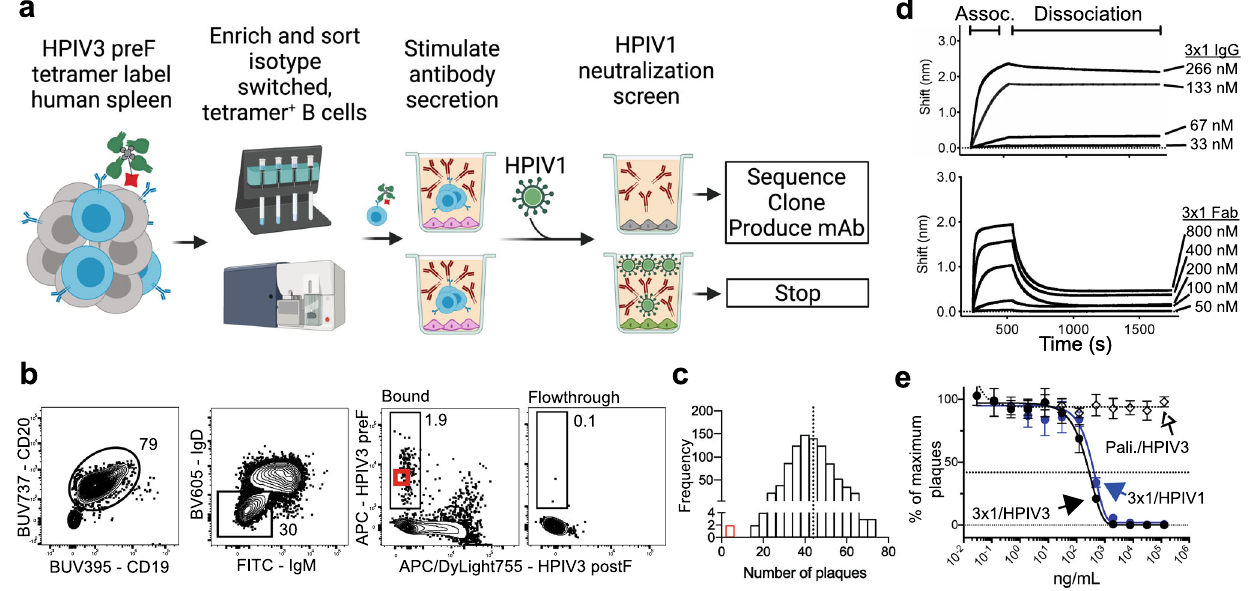
Fig. 1 | Identi fi cation of an HPIV3/HPIV1 cross-neutralizing monoclonal anti- body. a Bait-and-switch approach using a single antigen to identify B cells that cross-neutralize another related virus. HPIV3-binding B cells from human spleen were labeled with APC-conjugated tetramersofHPIV3 preF. b Flow cytometryplot of HPIV3 preF-binding B cells after gating for live, CD3 − CD14 − CD16 − CD19 + CD20 + (B cells), IgD − /IgM − (isotype-switched), and APC/Dylight755 − HPIV3 postF − (to exclude cells binding to HPIV3 postF, APC, or streptavidin). The bound fraction contains cells magneticallyenriched cellsusing APC-speci fi c microbeads. Numbers on plots